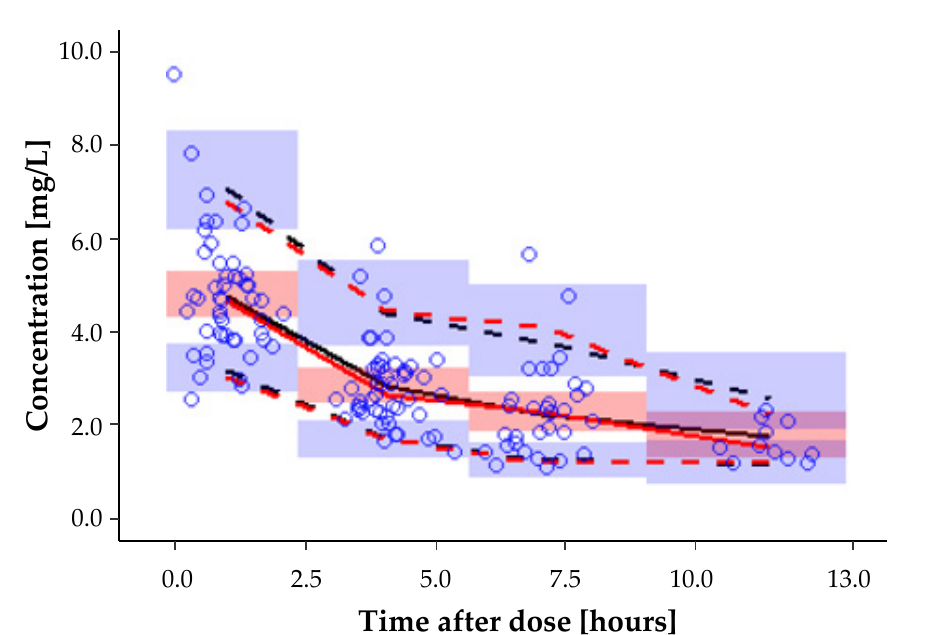
Figure 2. The visual predictive check (prediction-corrected) of the final PK model, showing the median, 5th, and 95th percentile of observed data (red lines) and the median, 5th, and 95th percentile of predicted data (black lines). The circles represent the prediction-corrected observed concentrations, and the shaded areas represent 95% confidence intervals.